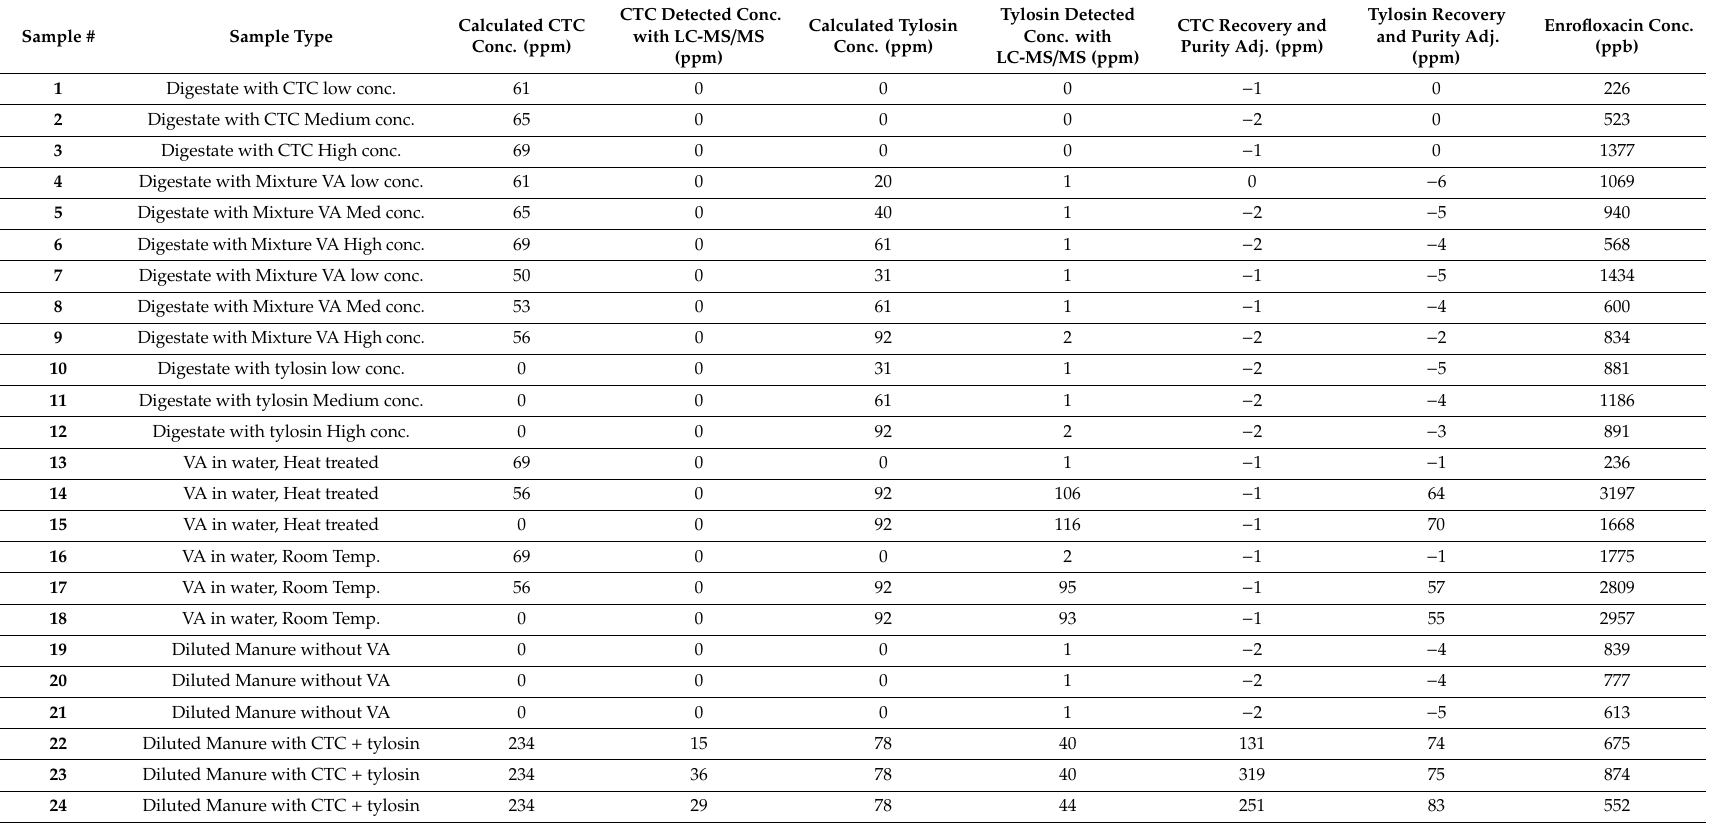
Table 6. Samples, their content and comparison between their calculated, detected by LC-MS / MS and adjusted